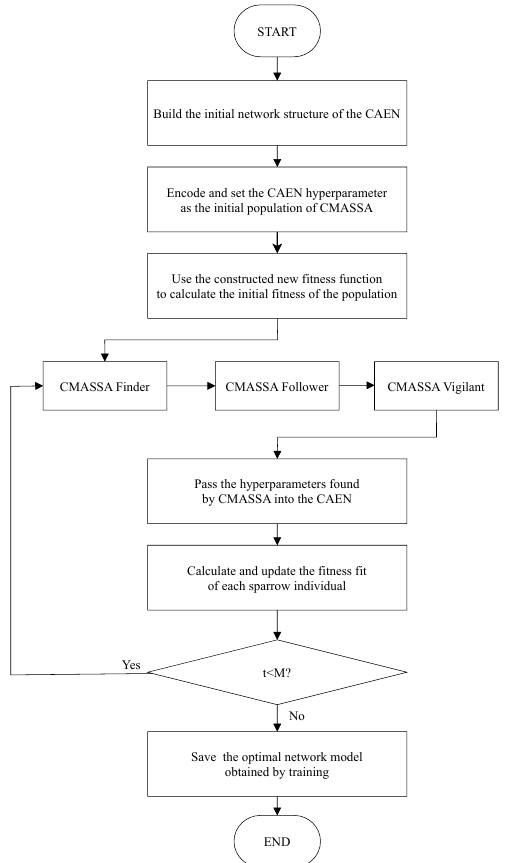
Figure 6. CMASSA-CAEN algorithm flow